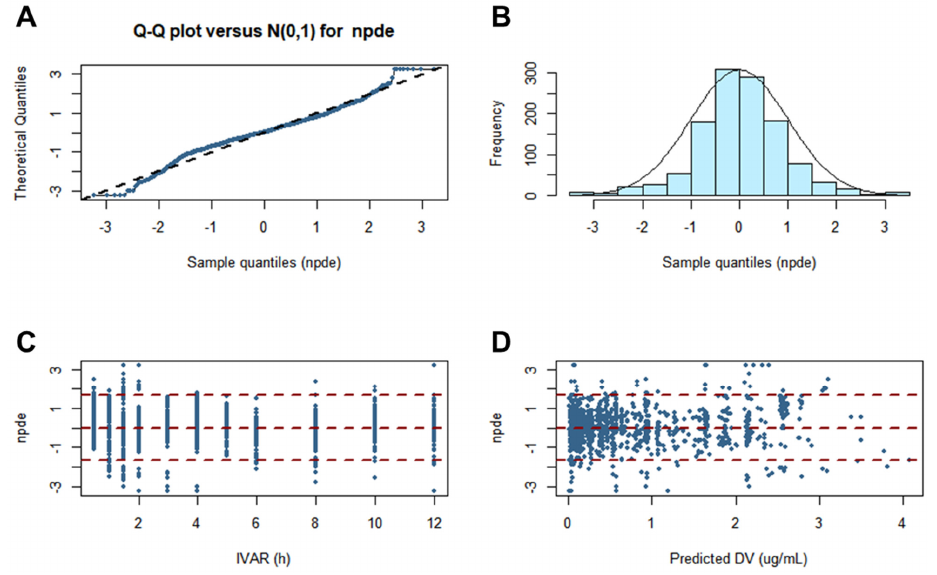
Figure 7. Graphs of NPDE results for the final torsemide Pop-PK model. Theoretical N (0, 1) distri- bution versus quantile–quantile plots of NPDE ( A ). Histogram showing the density of the standard Gaussian distribution and the distribution of superimposed NPDE ( B ). Scatter plot of the NPDE versus IVAR ( C ). Scatterplot of the NPDE versus predicted DV ( D